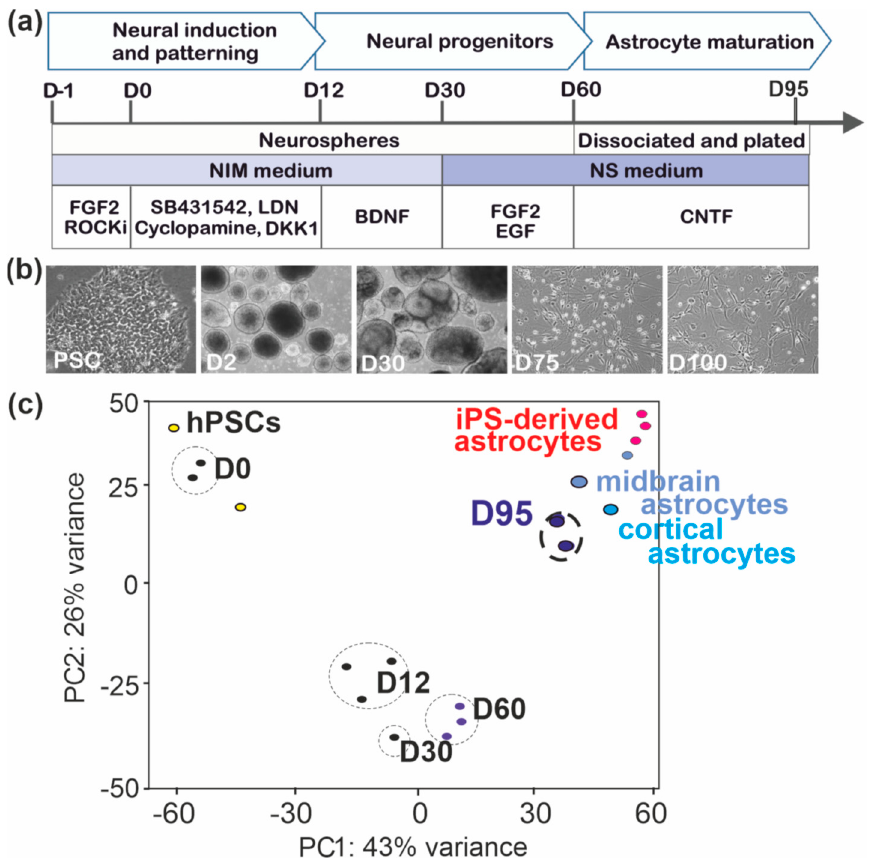
Figure 1. Differentiation of human pluripotent stem cell (hPSC)-derived astrocytes. ( a ) Schematic illustration of the astrocyte differentiation protocol. ( b ) Representative bright field images of cells at the different stages of differentiation; pluripotent cells (hPSCs), at Day 2 (D2), D30, D7), and D100 of differentiation. ( c ) Principal component analysis (PCA) of the RNA-seq data of hPSCs ( n = 2) and cells at D0 ( n = 2), D12 ( n = 3), D30 ( n = 2), D60 ( n = 3), and D95 ( n = 2) showed separated clustering of D95 astrocytes from the clusters of undifferentiated cells and D12, D30, and D60 cells. D95 astrocytes clustered together with human embryonic and hPSC-derived astrocytes published previously. Abbreviations: FGF2, fibroblast growth factor 2; ROCKi, ROCK inhibitor; DKK1, Dick- kopf 1; BDNF, brain-derived neurotrophic factor; EGF, epidermal growth factor; hPSCs, human pluripotent stem cells.